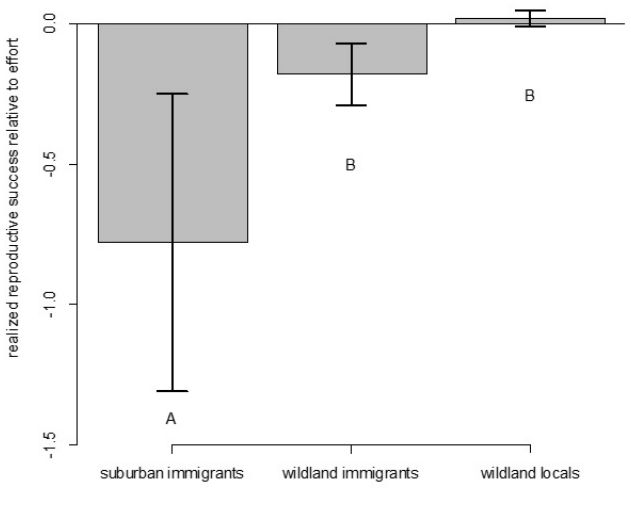
Fig. 2. Mean and SE of realized reproductive success relative to effort for suburban immigrant, wildland immigrant, and wildland local Florida Scrub-Jay individuals. Different letters indicate groups are significantly different from one